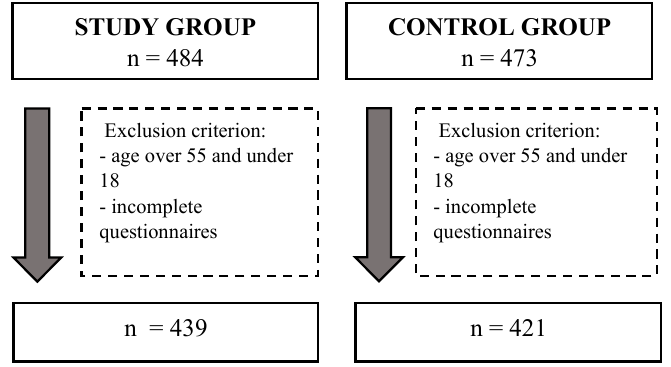
Figure 1. Flowchart. Figure 1.